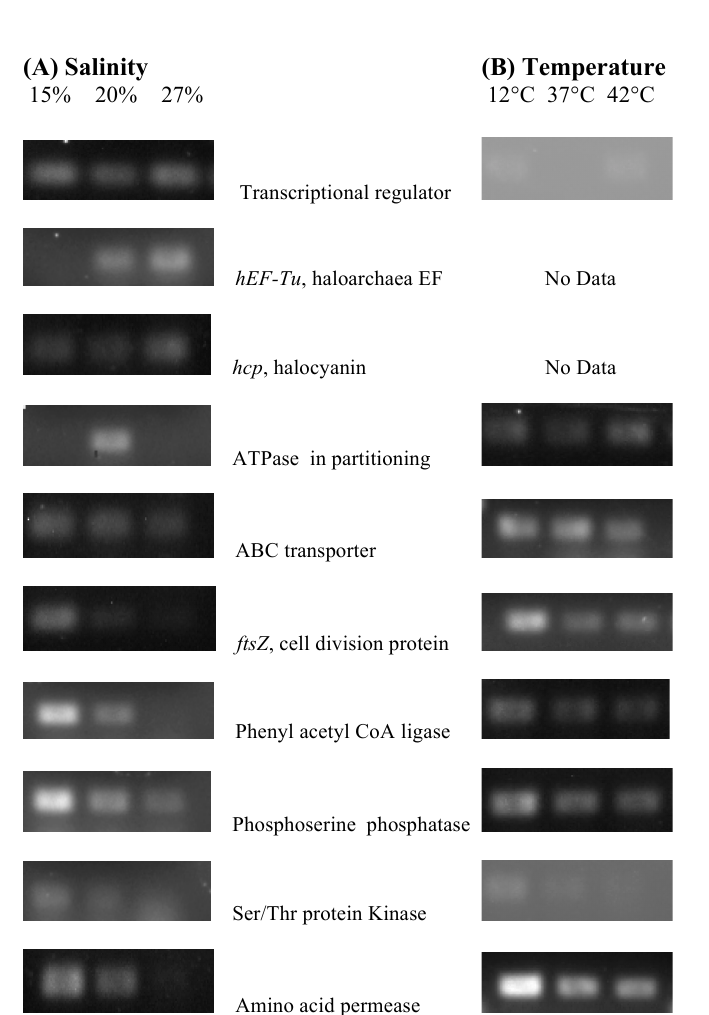
Figure 1. Confirmation of differential gene expression of RAP-PCR fragments in NA6-27 grown under the following conditions. ( A ) Salinity 15, 20, and 27% NaCl (w/v) and ( B ) Temperature 12, 37 and 42 °C. Quantitative PCR was performed using gene specific primers as described by Benson et al. [2–4]. Gel documentation photographs are aligned with data on genes for each growth condition.